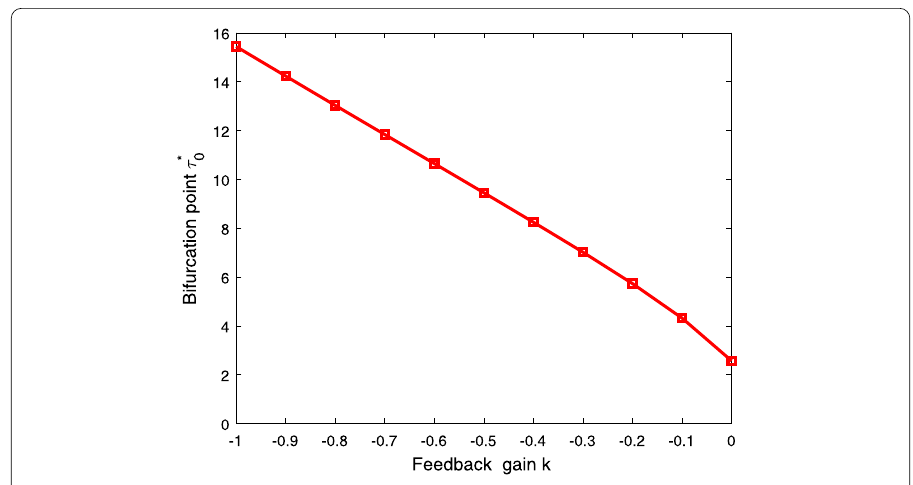
Figure 6 The influence of feedback gain k on τ ∗ 0